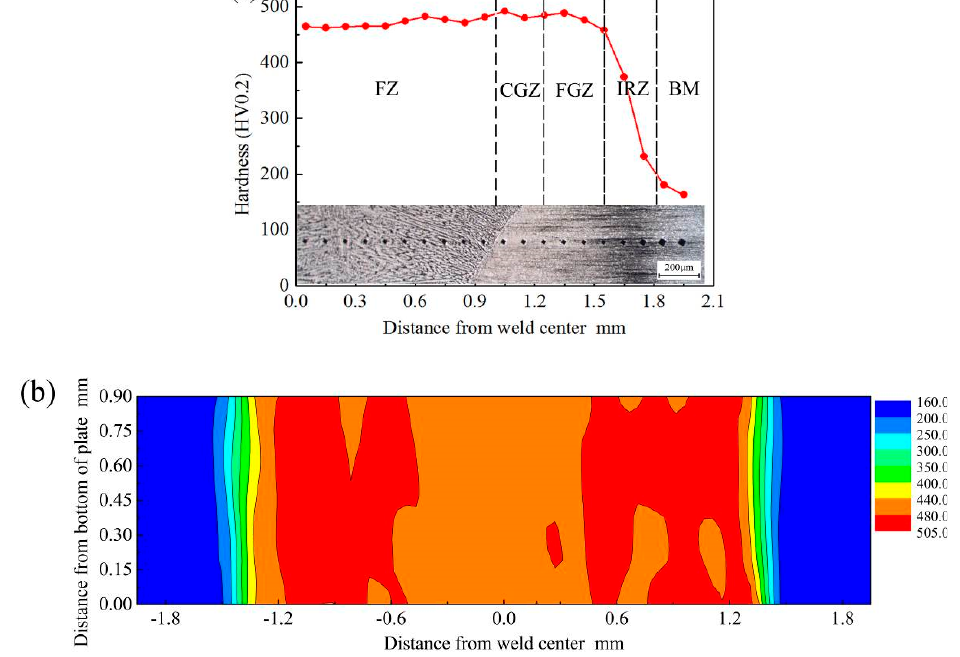
Figure 11. Hardness evolution ( a ) hardness distribution and grain morphology and ( b ) hardness map of the cross ‐ section of the weld joint.